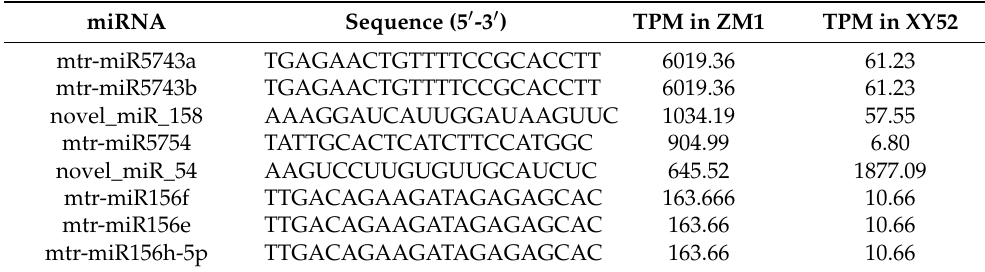
Figure 1. Differentially expressed miRNAs in alfalfa were determined using RNA-seq, and highly expressed miRNAs were quantified using RT-qPCR. Data are presented as the mean ± SD for n = 3/group. ** p < 0.01 was considered statistically significant. ( a ) A heat map of differentially expressed miRNAs in alfalfa, ( b ) relative expression levels of differentially expressed miRNAs, and ( c ) relative expression levels of cross-kingdom-regulated miRNAs. Table 5. miRNA sequences and TPM in alfalfa.